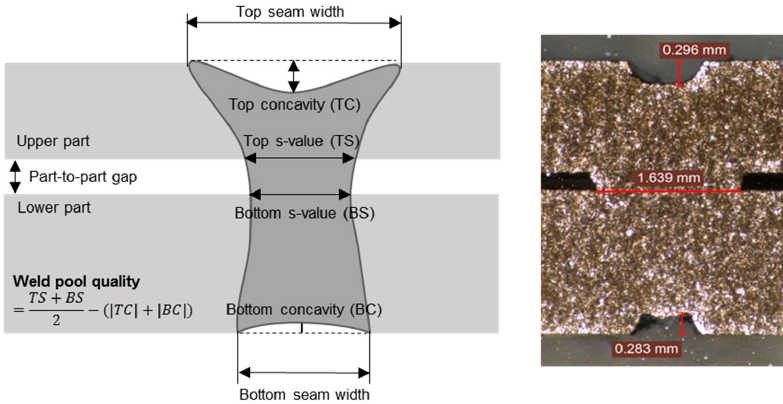
Figure 4. Definition of weld pool quality and an example of the cross sectional view at the middle of the specimen.